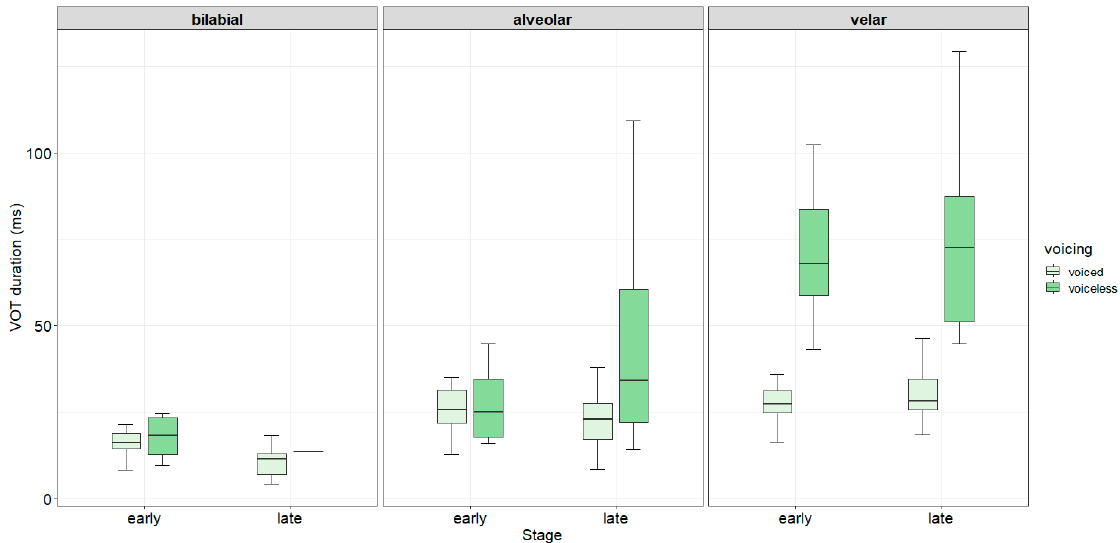
Figure 1. VOT durations (in milliseconds, ms) of AS’s German plosives.